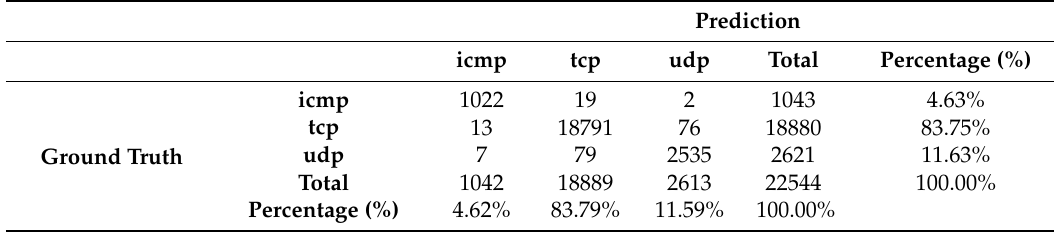
Table 3. Confusion matrix for reconstruction of all features values when feature: ‘ protocol’ is missing.